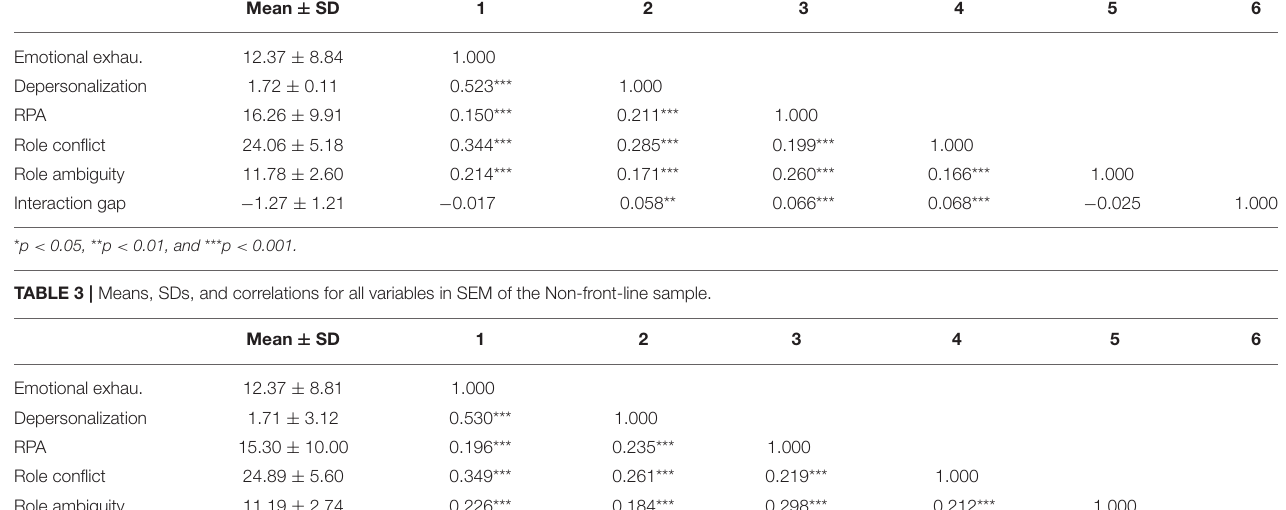
TABLE 2 | Means, SDs, and correlations for all variables in SEM of the Front-line sample. Mean ± SD 1 Emotional exhau.